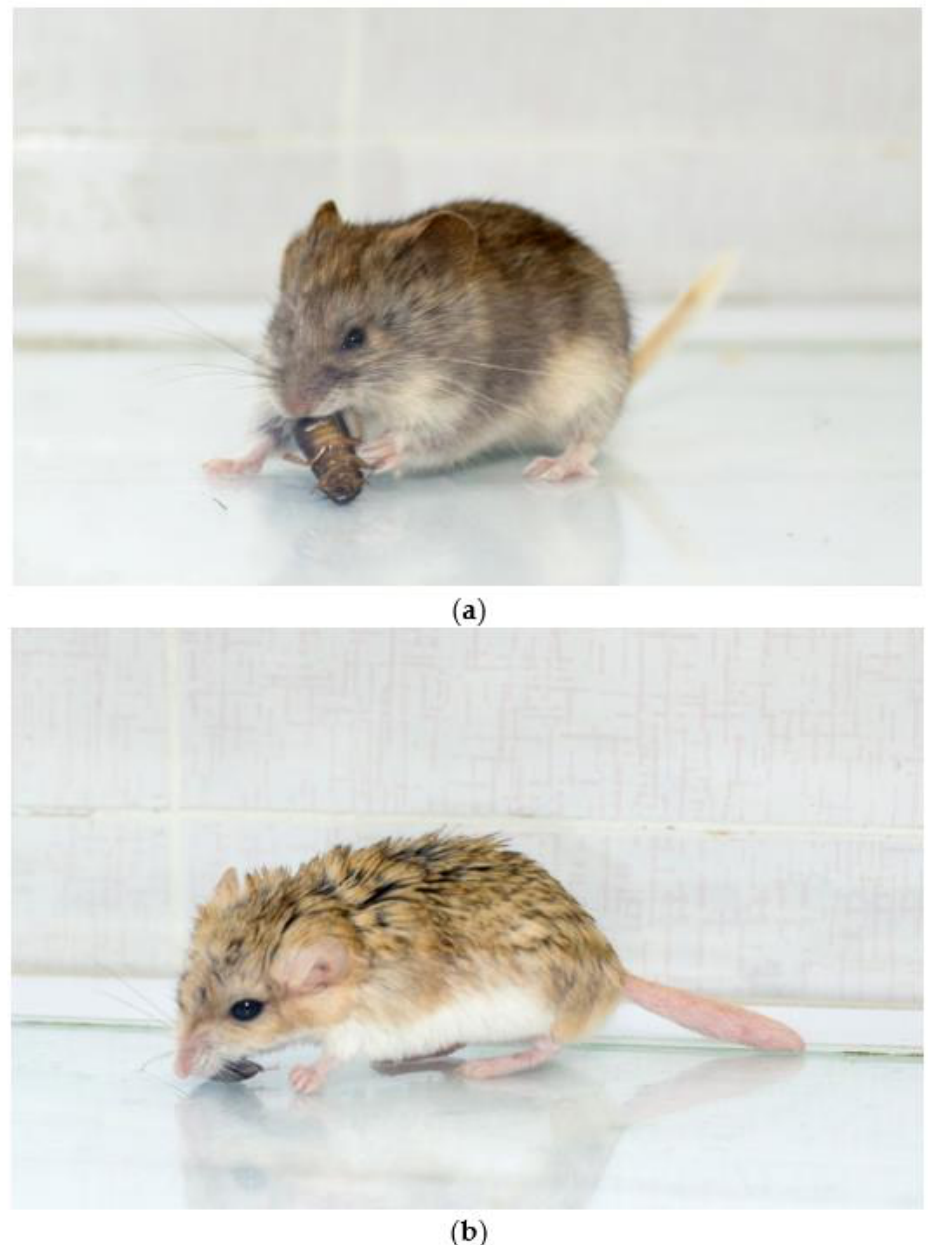
Figure 1. ( a ) a narrow-headed vole Lasiopodomys gregalis is handling the cockroach with its paws; ( b ) a fat-tailed gerbil Pachyuromys duprasi is attacking the prey. Photos made by Galina Azarkina.